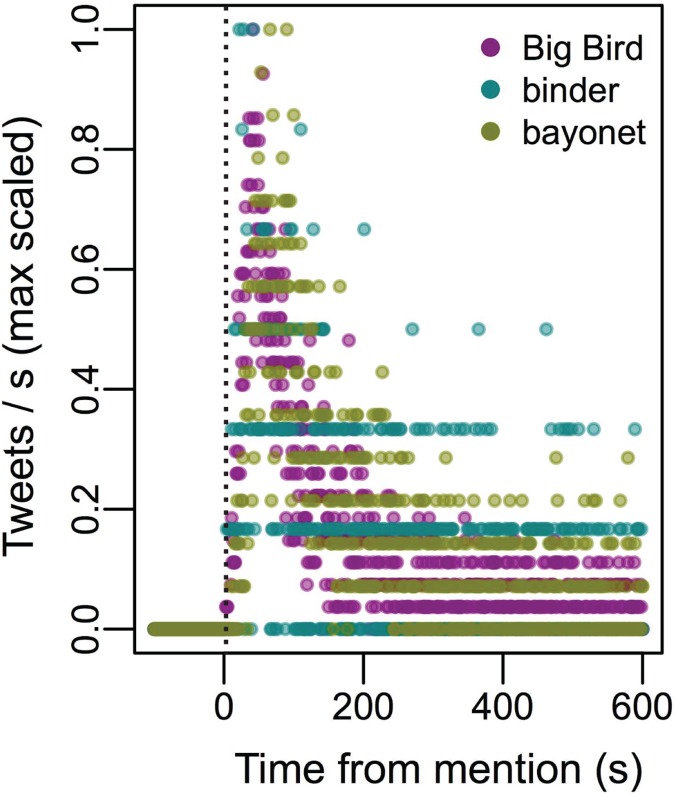
The temporal profile of public attention to salient events.At the onset of a salient event, mention of the word (in the context of either "Obama" or "Romney") rapidly rises within 10 seconds (left panel). Mentions are max scaled to facilitate comparison. Right panel shows retweets separately from original tweets, showing the expected delay. Interestingly, these salient events show distinct temporal signatures in their onset and rise to maximum, both in the profile of tweets and retweets. For original tweets, first mention for Big Bird, binder, and bayonet respectively is 4, 5, and 11 seconds; their maximum is achieved at 42, 23, and 67 seconds. In the retweet data, this is lagged, with first retweets at 31, 14, and 17 seconds; maximum achieved at 99, 80, and 78 seconds, respectively for Big Bird, binder, and bayonet.